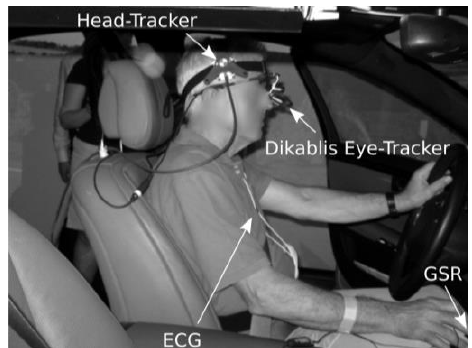
Fig. 1. Setup of the vital parameter sensors in the driving